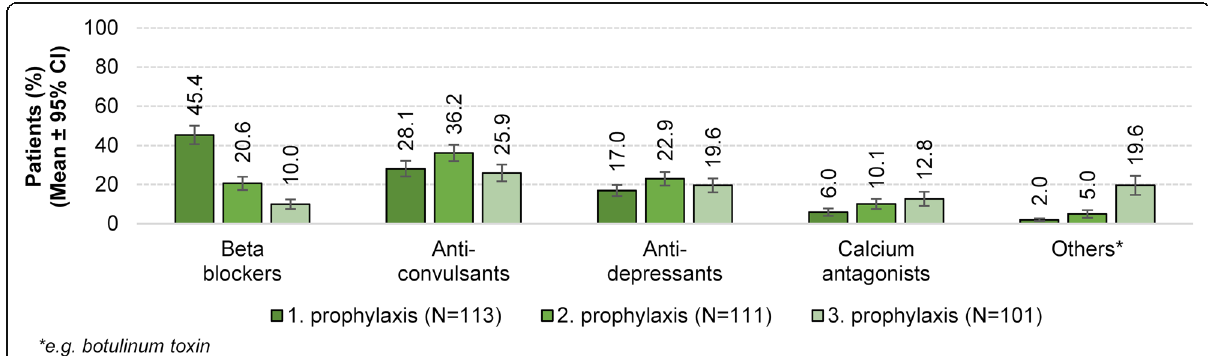
Fig. 5 Treatment sequence of prophylactic migraine substance classes (predefined answers, n = number of questionnaires included in the evaluation)